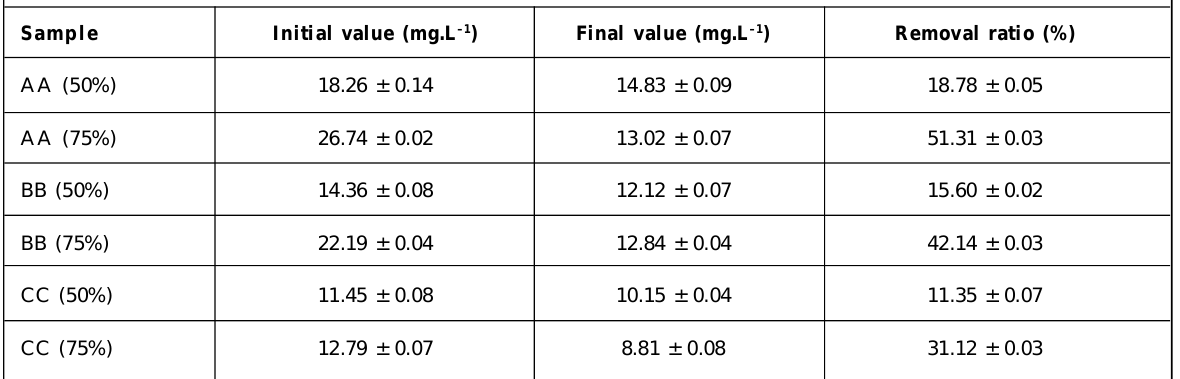
Table 3.1: Total nitrogen removal ratio in samples mixture of microalgae and industrial wastewater AA, BB, and CC with different proportions (50%, and 75%) removed by C.